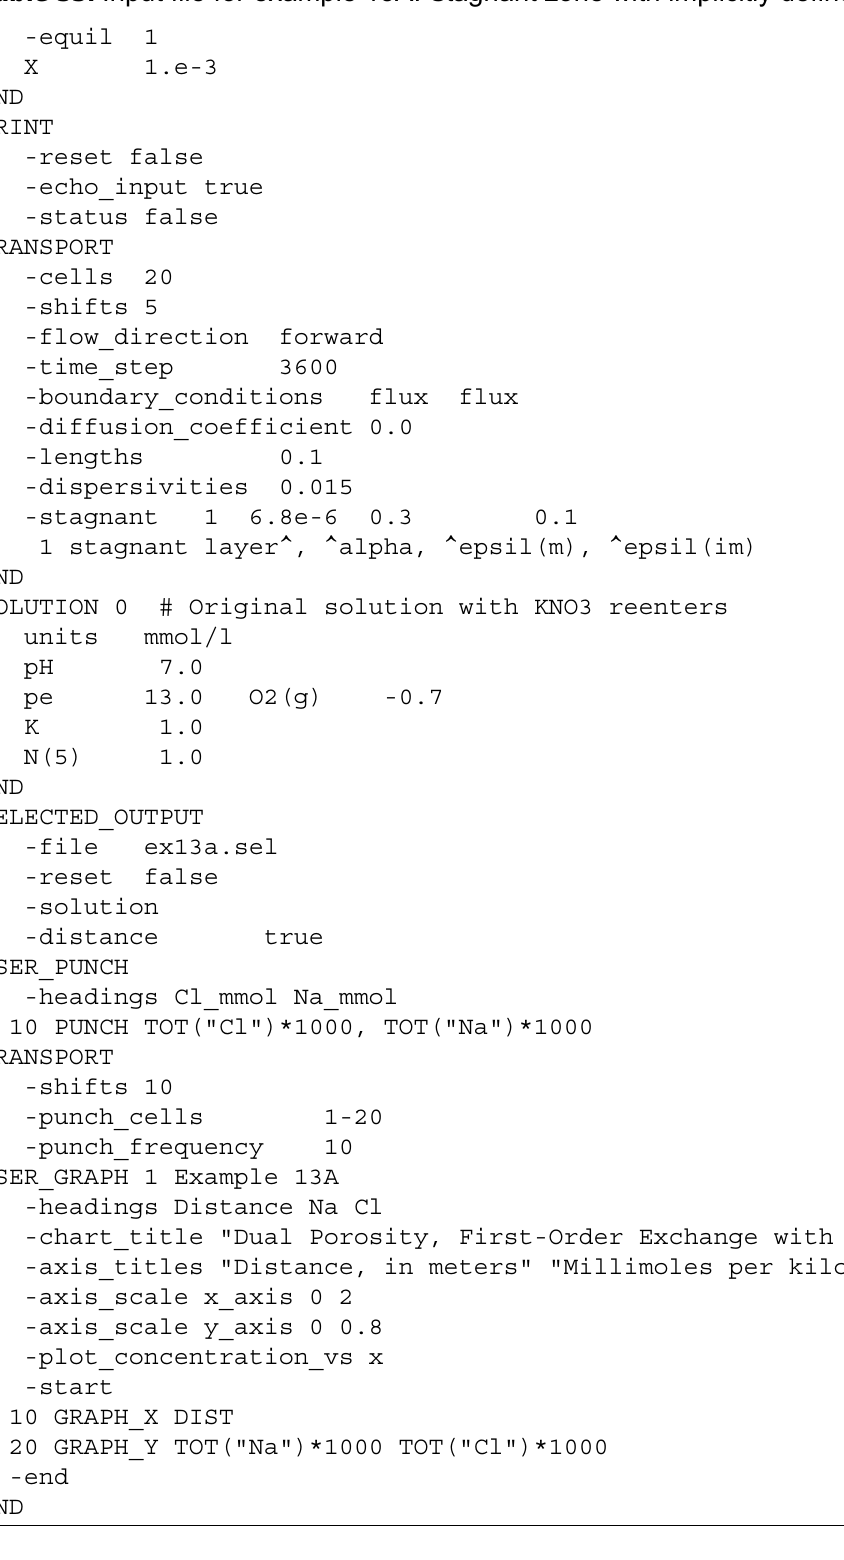
Table 33. Input file for example 13A: Stagnant zone with implicitly defined mixing